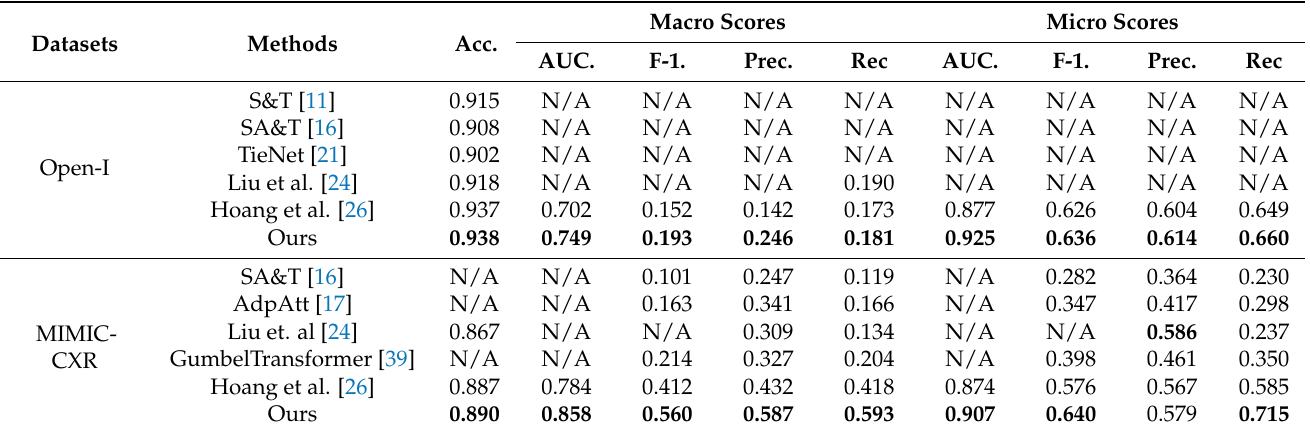
Table 2. The clinical accuracy of the generated reports was quantitatively compared by evaluating 14 common diseases defined together in the CheXpert and MIMIC-CXR datasets, with the best results highlighted using bold font.